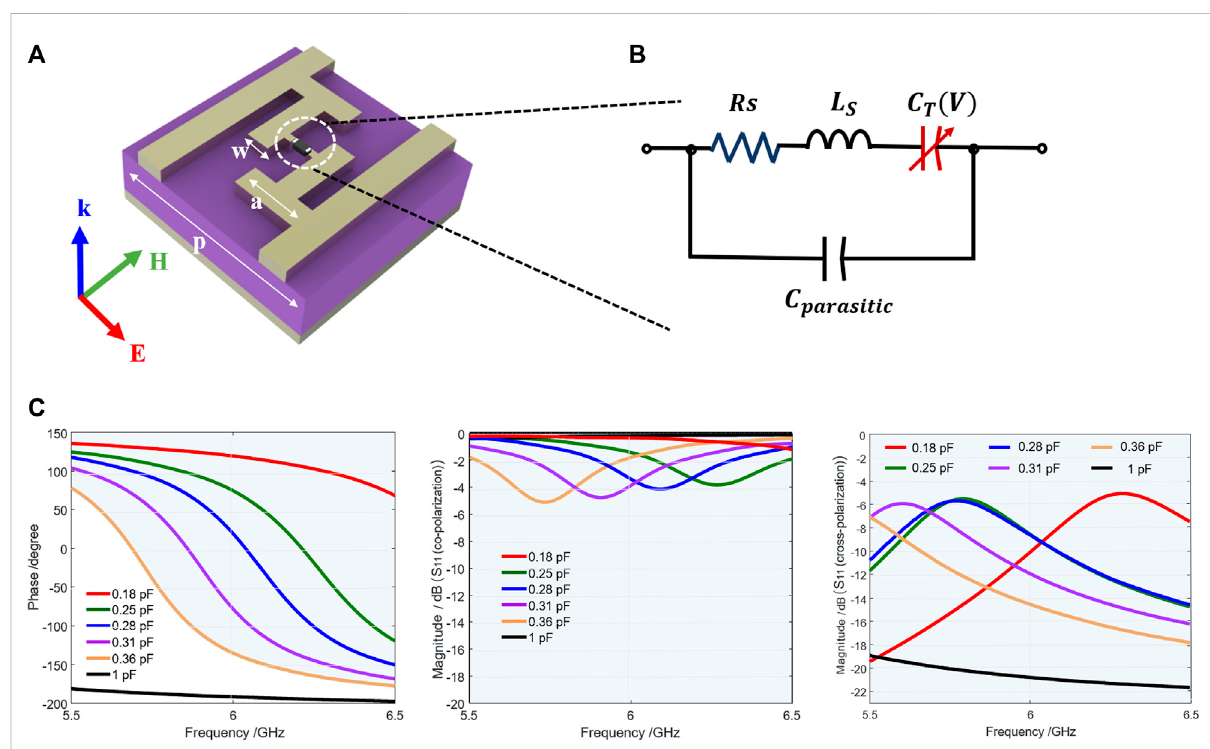
FIGURE 2 The unit cell and S-parameters. (A) 3D view of the designed unit cell. p (cid:1) 9mm , a (cid:1) 4mm , w (cid:1) 2mm , b (cid:1) 5mm . (B) Equivalent circuit diagram of the diode ma46h120, diode characteristics could be changed by adjusting the value of the capacitance. (C) The re fl ection phase of co-polarization, the amplitude of co-polarization and cross-polarization at different